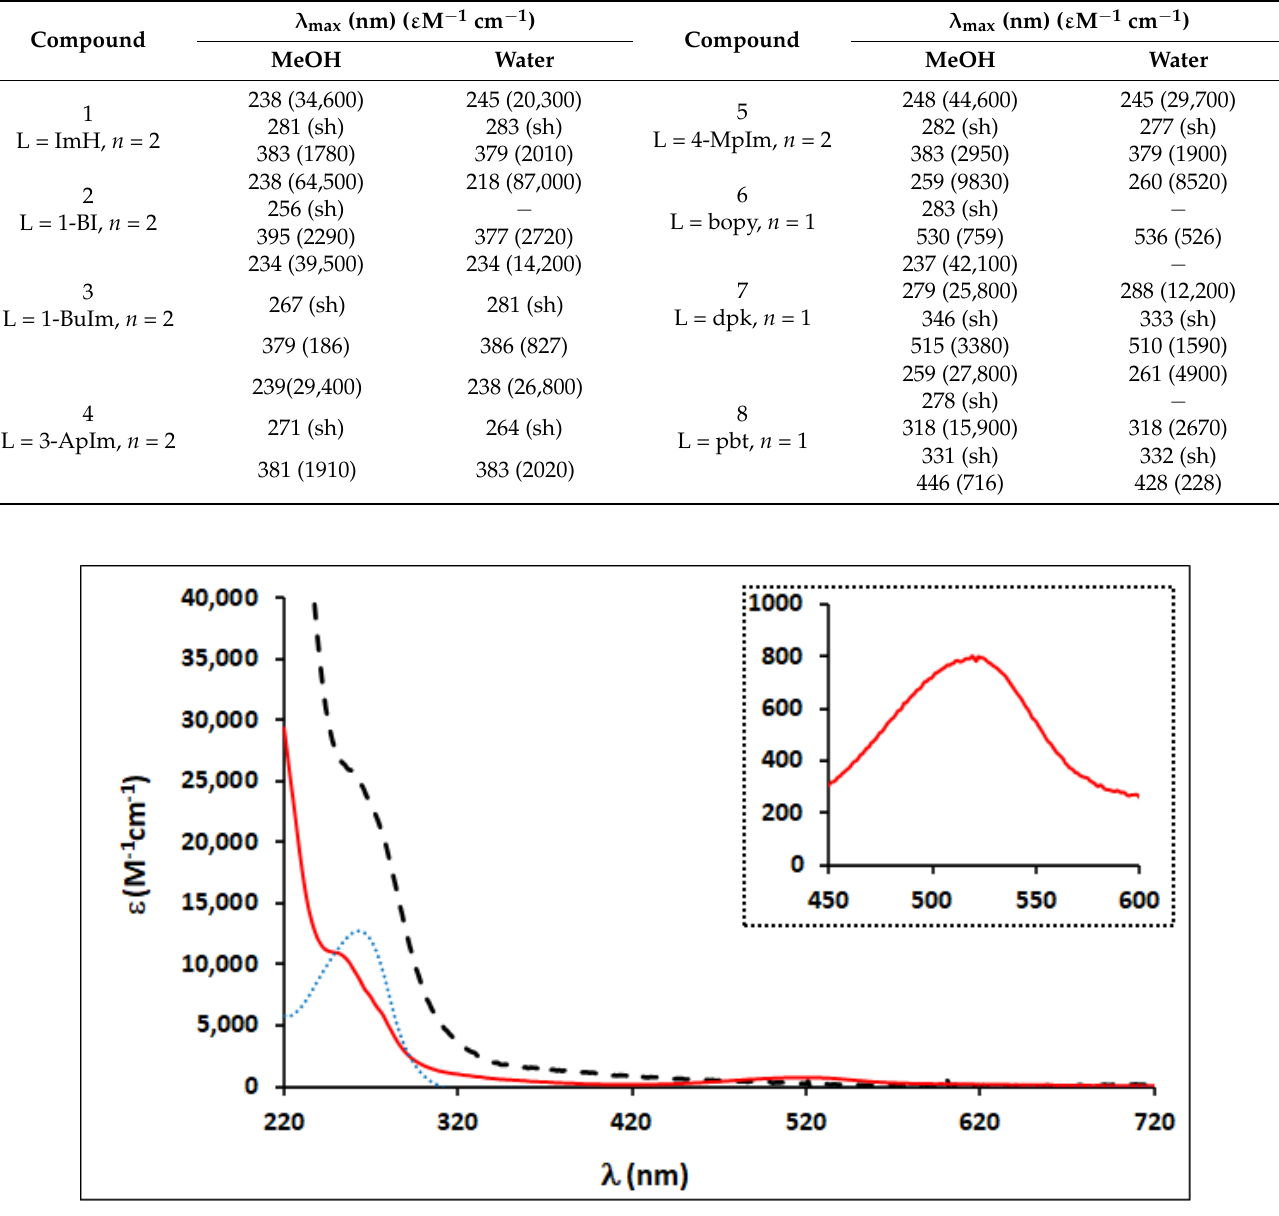
Table 1. Electronic spectra data for complexes 1 – 8 of general formula [Ru( η 5 -C 5 H 5 )( m TPPMSNa) n (L)] [CF 3 SO 3 ] in methanol and water solutions.